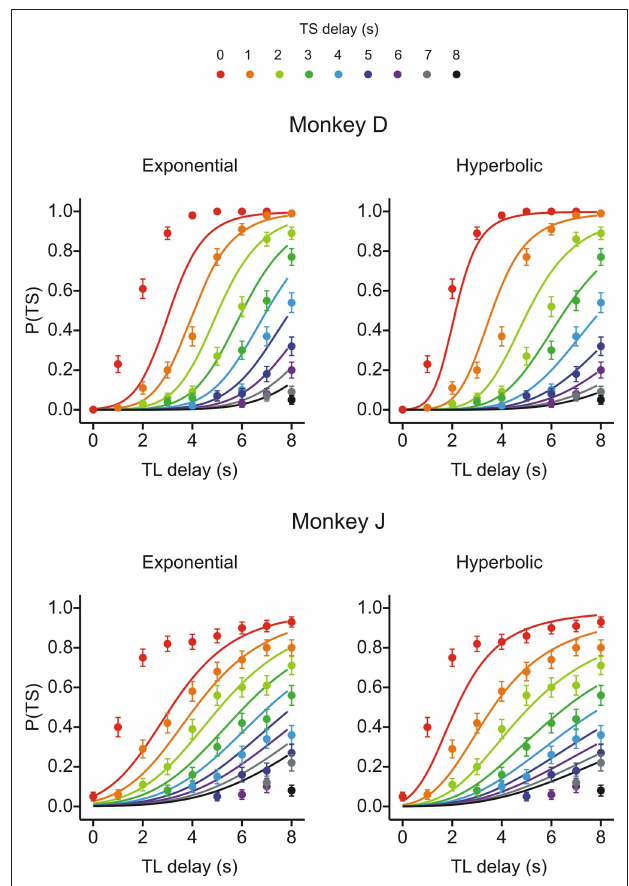
FIGURE 5 | Choice behaviors in Experiment II-A. Same format as in Figure 2